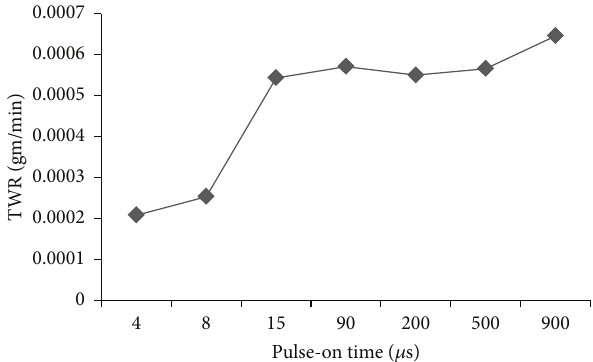
Figure 12: Influence of gap voltage on MRR at constant current 9Amp, pulse-on time 90 𝜇 s, and pulse-off time 90 𝜇 s.